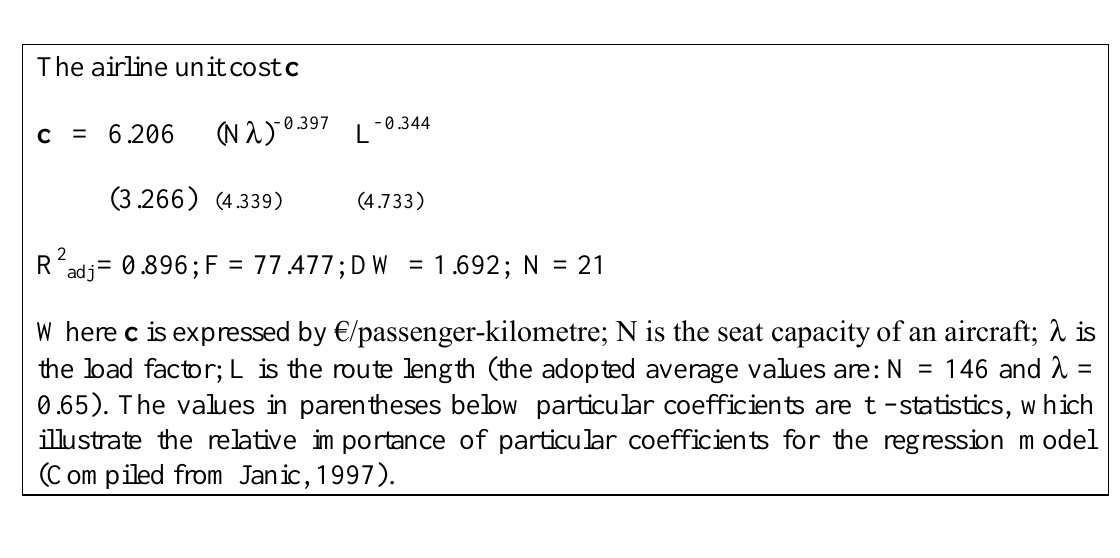
Table 2. The models used to determine the airline and airport unit cost per service in a given